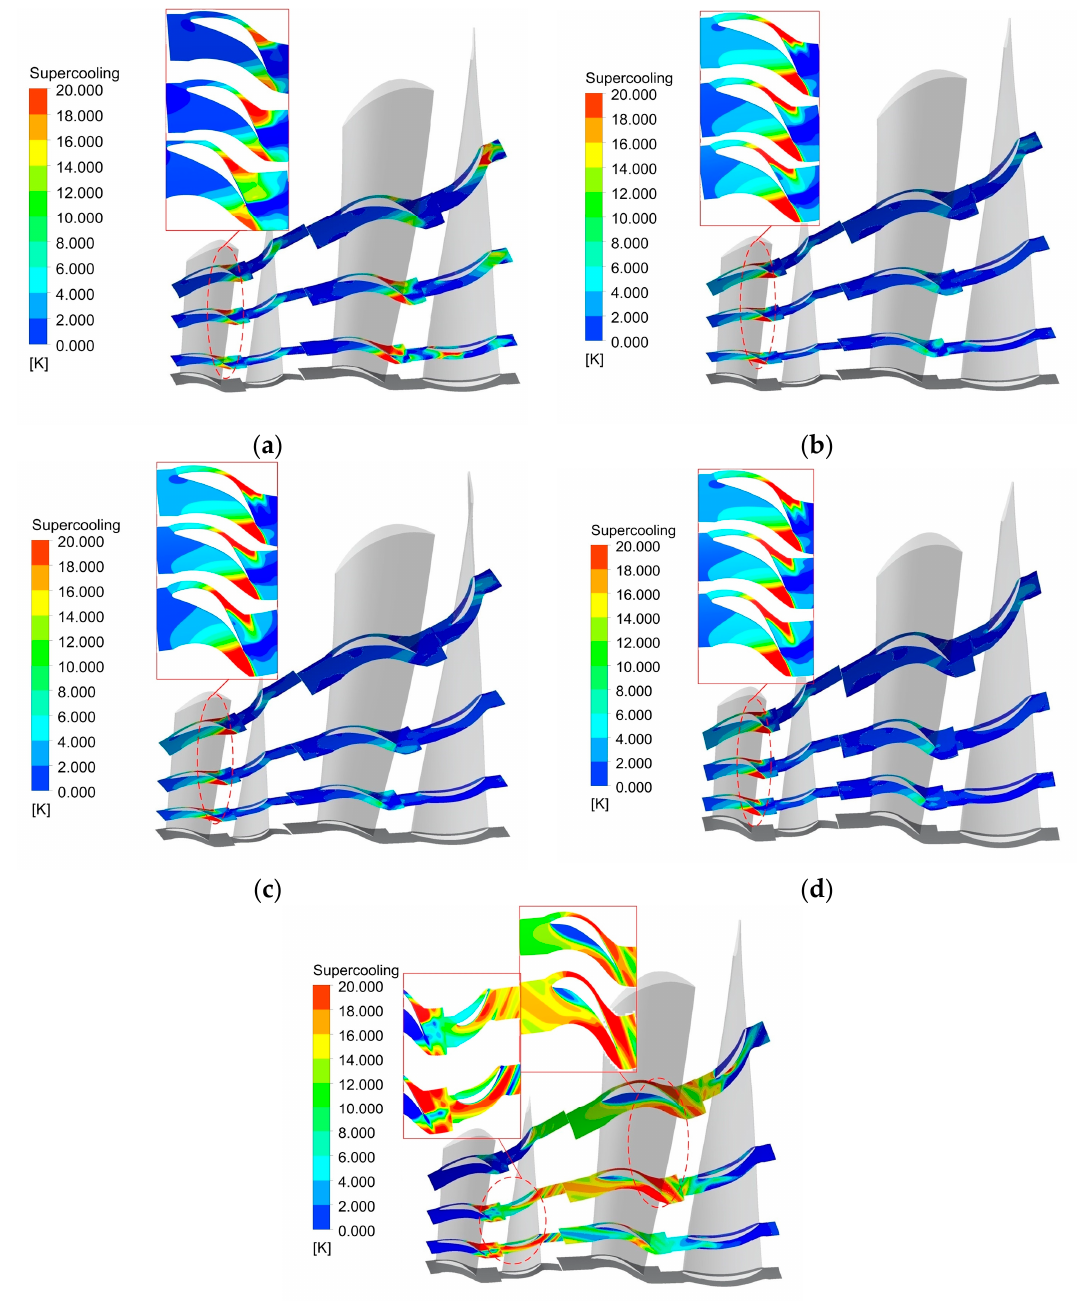
Figure 4. The distribution of supercooling degree along the blade height of steam turbine under different working conditions. ( a – e ), respectively, represent 100%, 50%, 40%, 30%, and 20% THA.